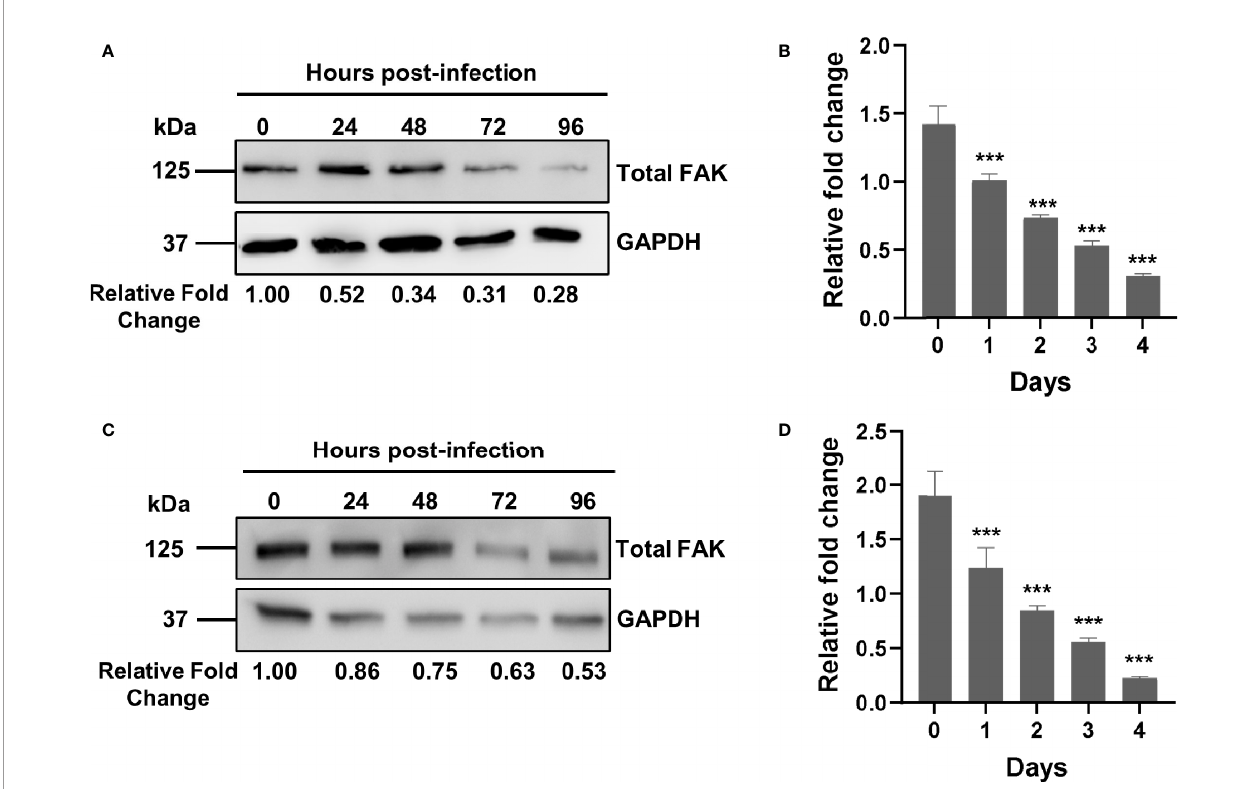
FIGURE 1 | Mtb infection downregulates FAK expression. (A) THP-1 macrophages were infected with Mtb at a multiplicity of infection (MOI) of 10. Cell lysates were prepared at the indicated time points post-infection, and total FAK protein levels were analyzed by western blot. (B) PTK2 expression levels in THP-1 macrophages infected with Mtb as in (A) were quanti fi ed using qRT-PCR at the indicated days post infection. (C) RAW 264.7 cells were infected Mtb as in (A) , and cell lysates were prepared at the indicated time post infection. Blots shown in (A, B) are representative of three independent experiments. Densitometry analysis of the blots was performed using Image Quant LAS 4000 software with intensities normalized to GAPDH. Relative fold change of total FAK levels was expressed relative to uninfected cells. (D) Ptk2 expression levels in RAW 264.7 macrophages were measured as in (B) . qRT-PCR data were analysed using the DD CT method normalizing to (B) ACTB or (D) GAPDH as a reference gene, and fold change is expressed relative to uninfected cells. qRT-PCR data represent the mean of three replicates. *** p <